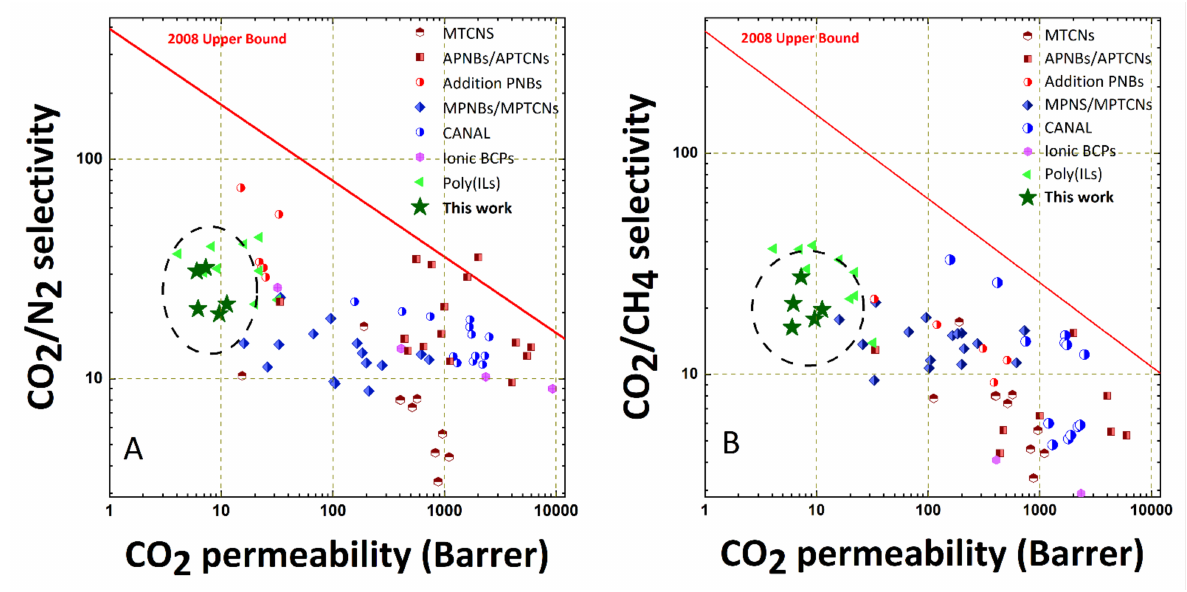
Figure 5. Robeson upper bound plot [55] for comparing the ( A ) CO 2 /N 2 and ( B ) CO 2 /CH 4 separation performance of the studied p [NBM-mIm][Tf 2 N] and BCPs membranes. Data from the reported literature values poly(IL)s [24,25,27], ionic BCPs [39,46], and norbornene-based polymers [34] were taken for comparison